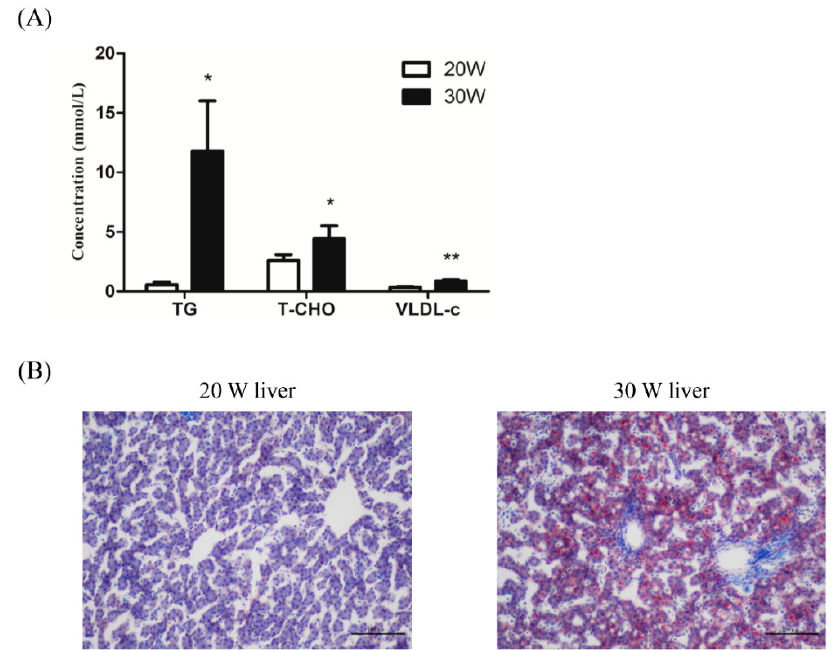
Figure 1. Increased lipid metabolism occurs in the liver of peak-laying hens compared with that in pre-laying hens. ( A ) ELISA analysis of the concentrations of TG, T-CHO and VLDL in the serums of pre-laying (20 weeks old) and peak-laying (30 weeks old) hens ( n = 6 for each group). * p < 0.05, ** p < 0.01; ( B ) the di ff erence in the lipid droplet accumulation in the liver of pre-laying (20 weeks old) and peak-laying (30 weeks old) hens as determined by oil red O staining. Scale bar: 100 µ m.